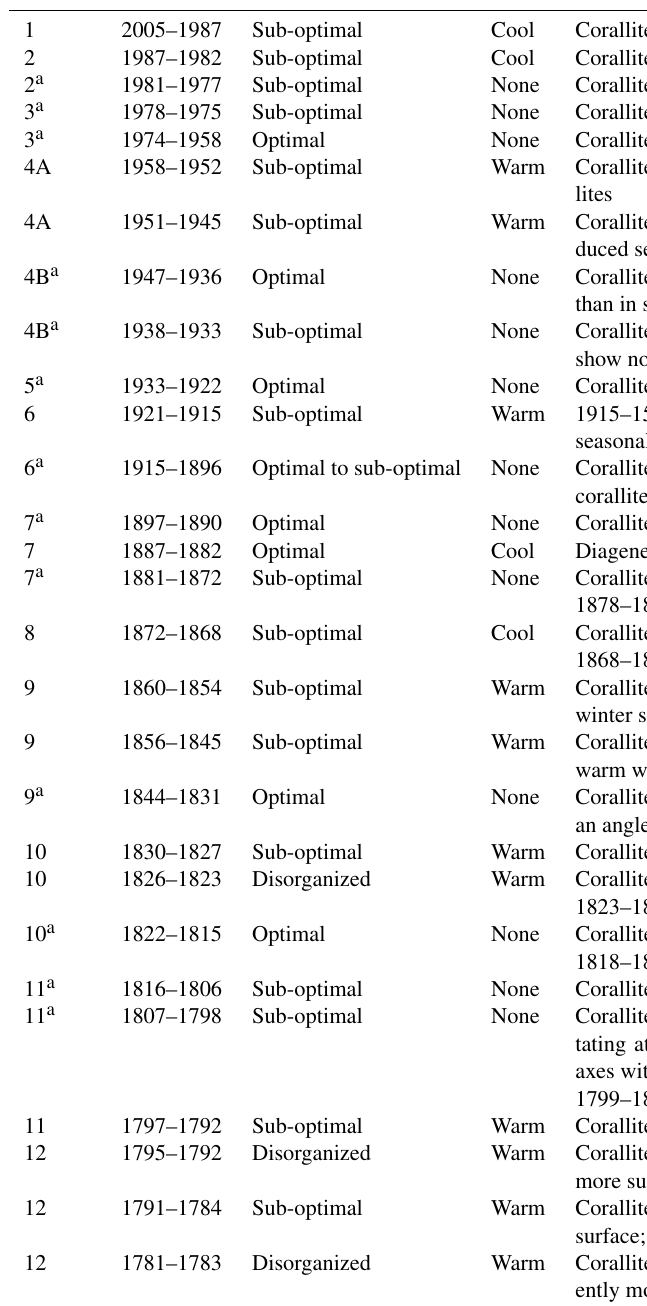
Table 2. Summary of sampling issues detected in core Totor.